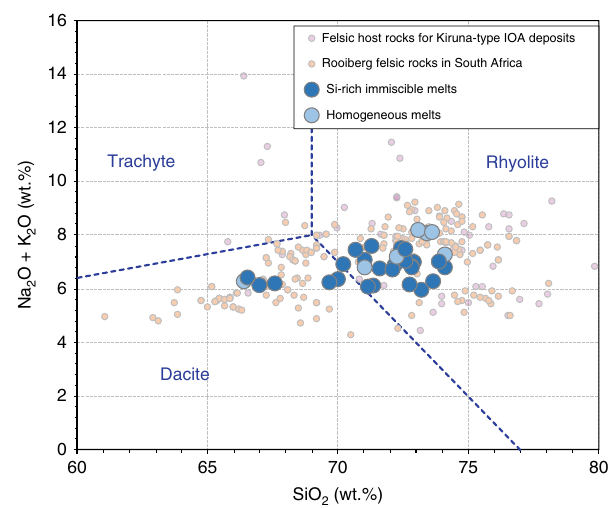
Fig. 3 TAS diagram showing the experimental dacitic and rhyolitic